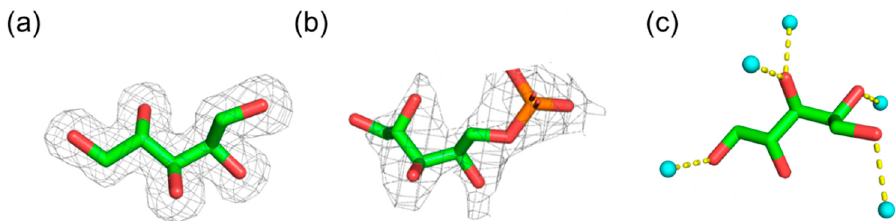
Figure 2. Representative 3D structure of ribitol and ribitol phosphate extracted from the database. ( a ) Crystal structure of ribitol (PDB ID: 5IAI). ( b ) Ribitol phosphate (PDB ID: 6H4F). ( c ) Ribitol interacting with water molecules (PDB ID: 4A0S). The structures are shown in stick representation. In ( a , b ), the electron density map is depicted in gray mesh contoured at 2.0 σ level. Proteins are omitted for clarity. In ( c ), water molecules hydrogen bonded with ribitol are shown in cyan sphere. The dihedral angles of the carbon main chain and the C1–C5 distance of extracted structures are listed in Table 1. Although the data are limited, one can examine the stable conformations for each dihedral angle. In each structure, the dihedral angles suggest staggered conformations. Except for one example (6H4M), the four dihedral angles ( ϕ 1– ϕ 4) do not all simultaneously assume anti-conformations; some prefer bent conformations. Table 1. Main chain dihedral angles ( ◦ ), C1–C5 distance (Å), and resolution (Å) of ribitol and ribitol phosphate extracted from the CCDC and the PDB. NA; not